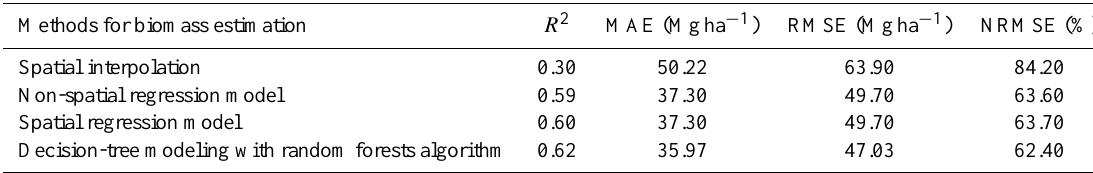
estimates from the spatial regression model (2.13 × 10 9 Mg) and RF (2.26 × 10 9 Mg) (Fig.